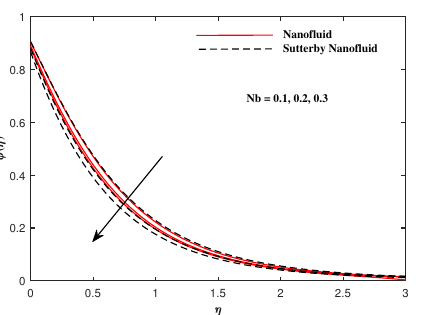
Figure 12. φ ( η ) fluctuate with Nb and Nt